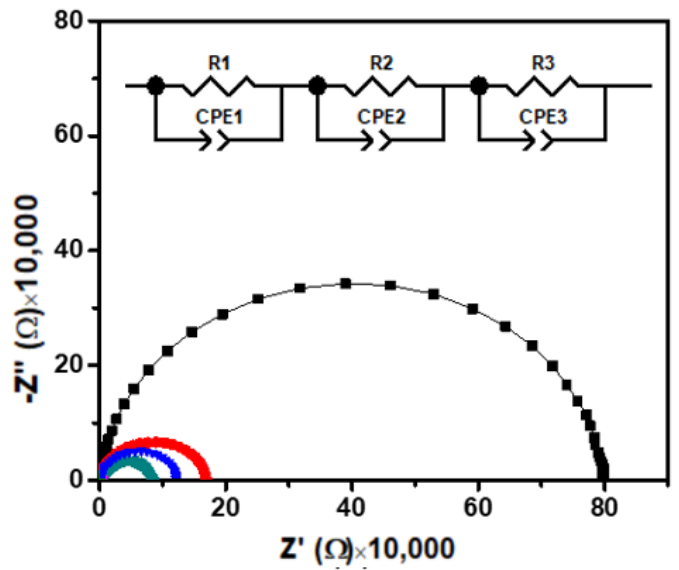
Figure 4. Nyquist plots of Ca 2 Fe 2 O 5 at different temperatures. Inset shows the equivalent circuit used to fit the data, where R1, R2, and R3 are contributions due to grain ( R g ), grain boundary ( R gb ), and interface ( R el ), respectively. Similarly, CPE1, CPE2, and CPE3 represent the capacitance due to grain ( C g ), boundary ( C gb ), and interface ( C el ), respectively. (Black, red, blue, and green represent the measurements at 25, 100, 150, and 200 °C, respectively. The data measured at 250 and 300 °C are not seen due to overlap near the origin with lower temperature data.)